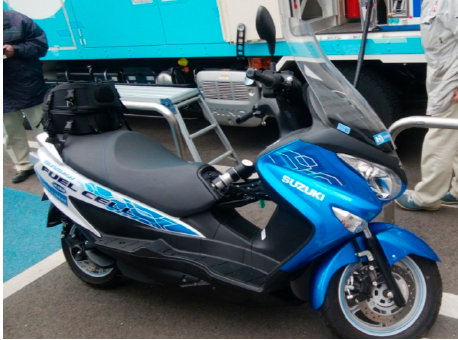
Figure 1. A fuel cell motorcycle at a hydrogen station in Japan.